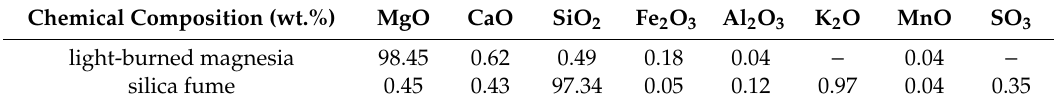
Table 1. Chemical composition of light-burned magnesia and silica fume (wt.%). Chemical Composition